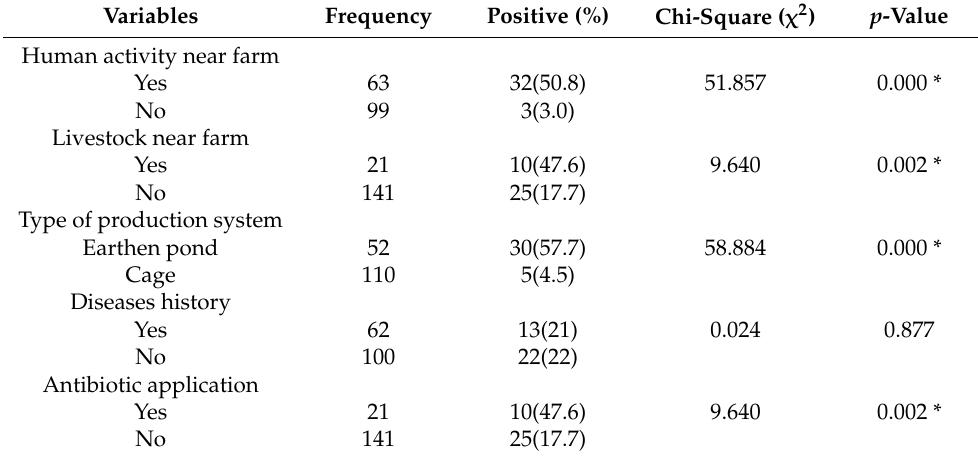
Table 3. Univariable analysis for risk factors associated with the occurrence of MDR V.